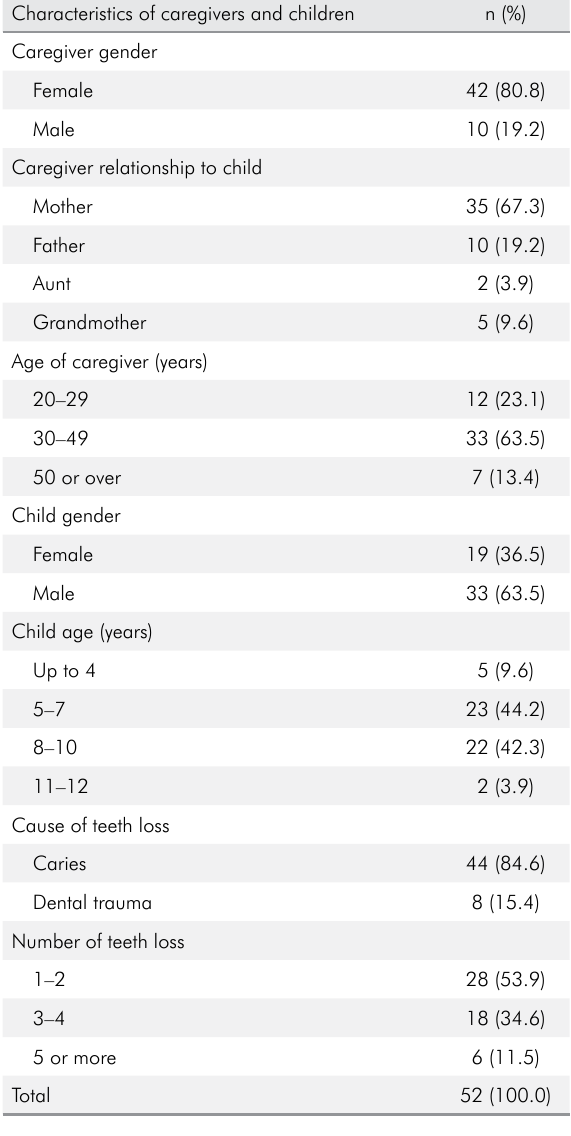
Table. Description of participants. Characteristics of caregivers and